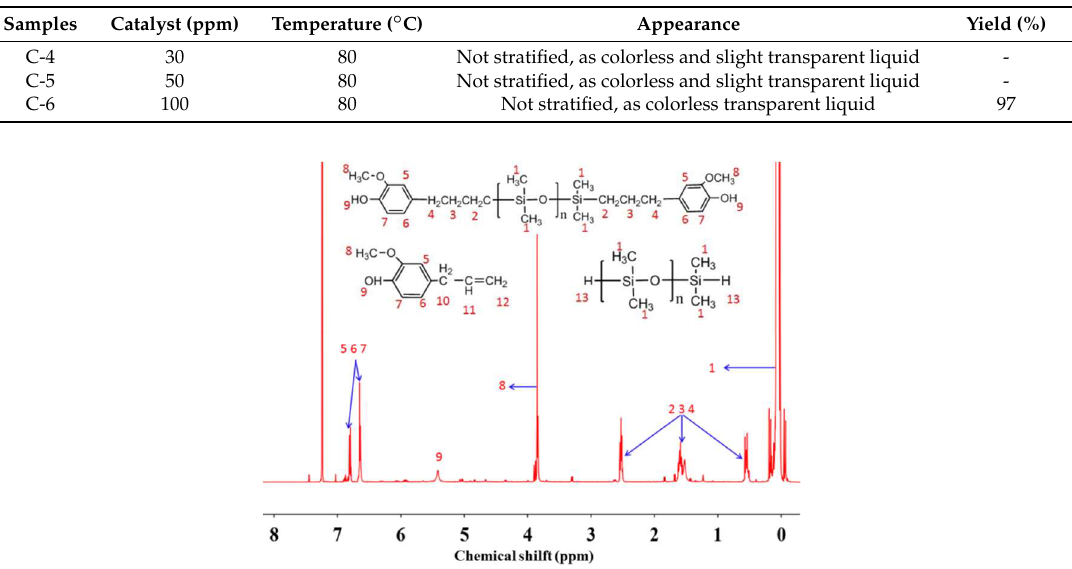
Table 6. Effect of catalyst concentration on activity of catalyst.